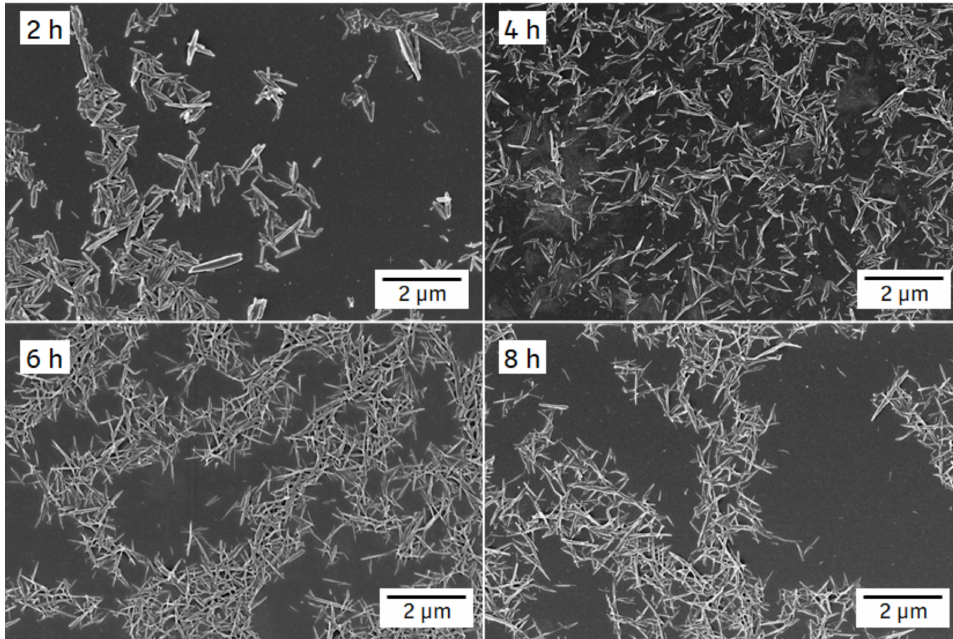
Figure 9. SEM images of F6 ITZ nanosuspension after different milling periods (indicated in the left upper corner of each image). Milling was carried out at 4 ◦ C with 1500 rpm and milling beads sized 0.3–0.4